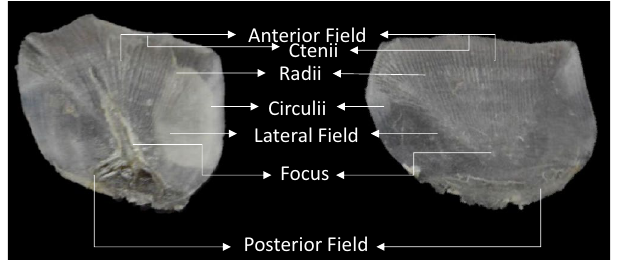
Figure 1. Morphology of the ctenoid scales from Argyrosomus thorpei (Photo by ©L. Shuttleworth, edited in MS PowerPoint Build